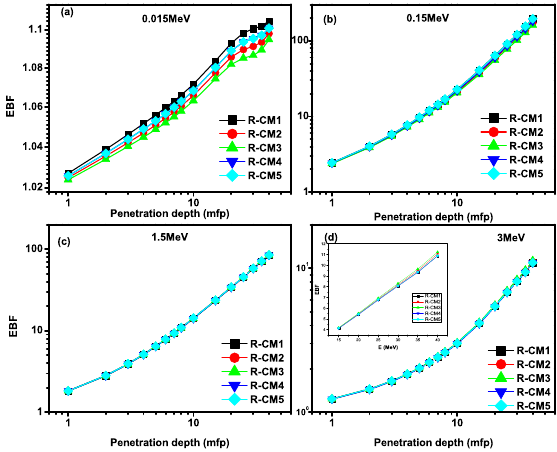
Figure 8: The EBF and penetration depth at photon energies 0.015, 0.15, 1.5 and 3 MeV.